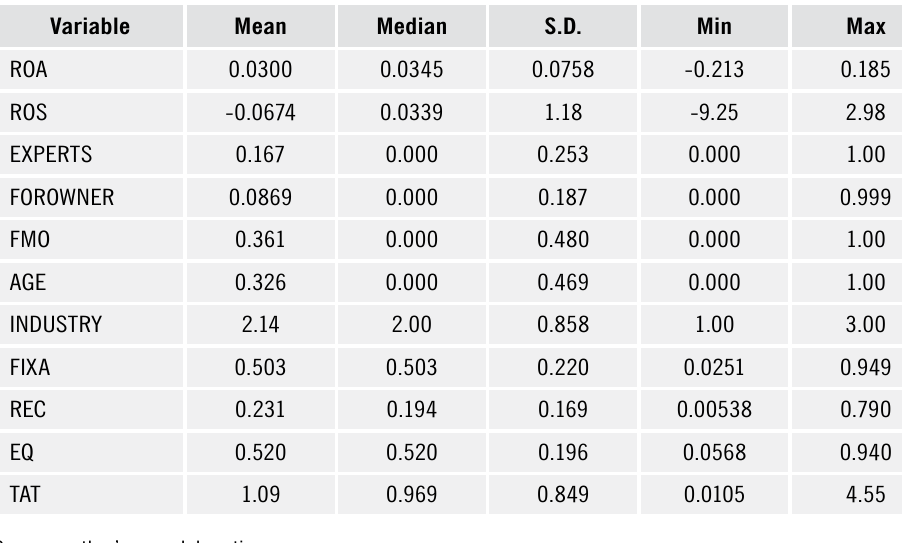
Table 4. Summary Statistics